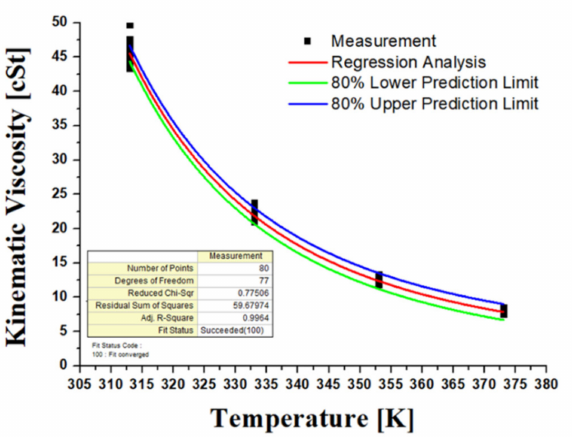
Figure 4. The correlation between kinematic viscosity and temperature using the Vogel model.